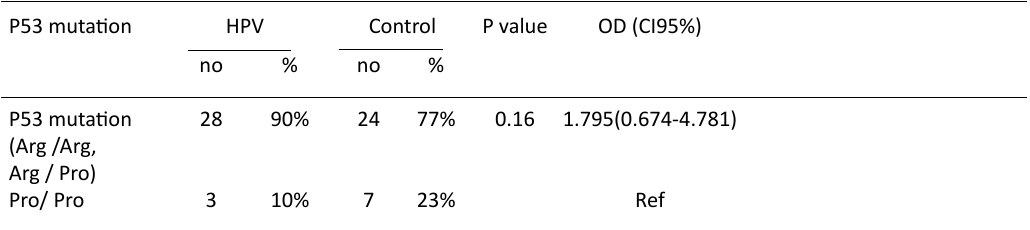
Arg; Arginine, Pro; Proline, CI(95%): 95% confidence interval, OR: Odds ratio, Ref: the reference